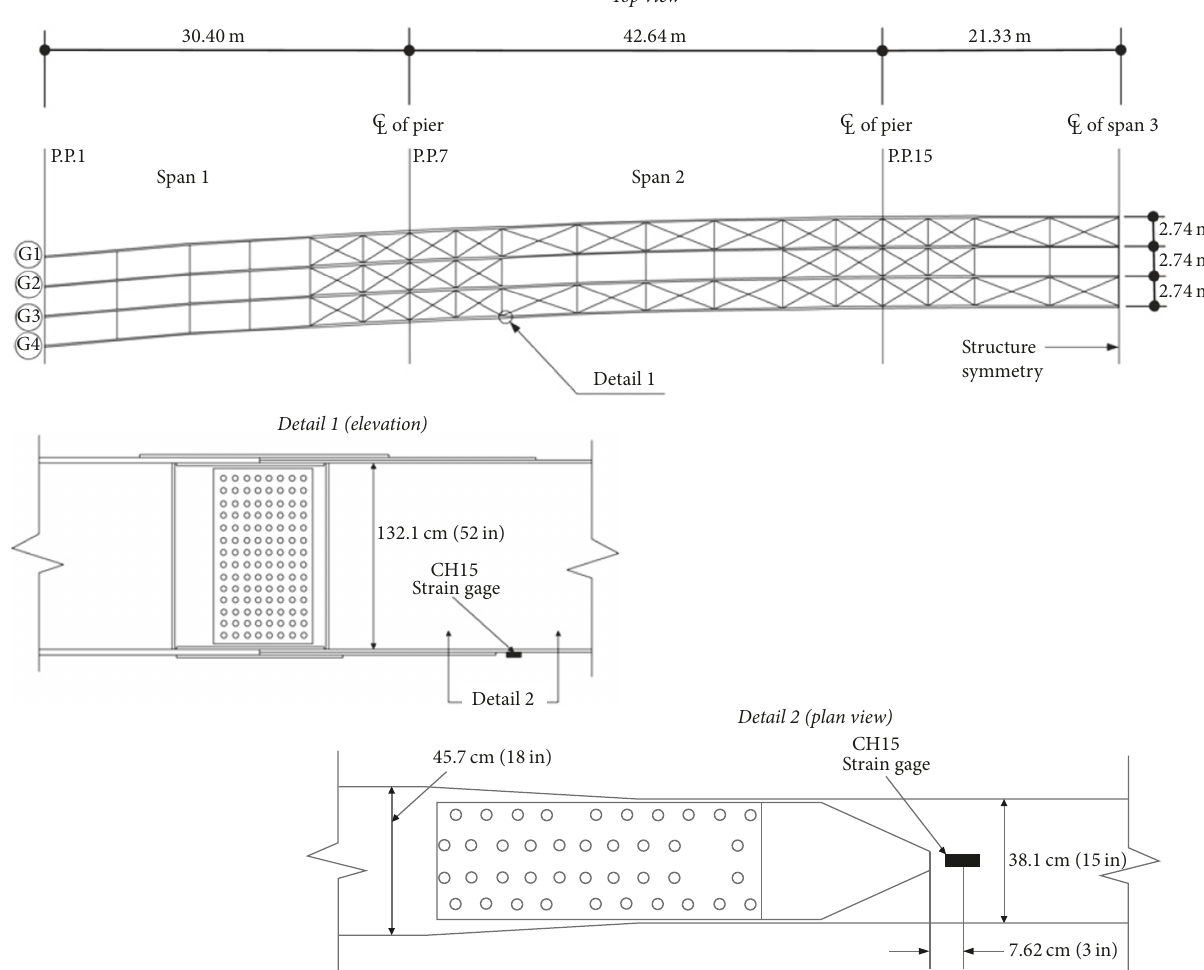
Figure 4: I-39 northbound bridge, instrumentation plan of the strain gage, CH15 (adapted from